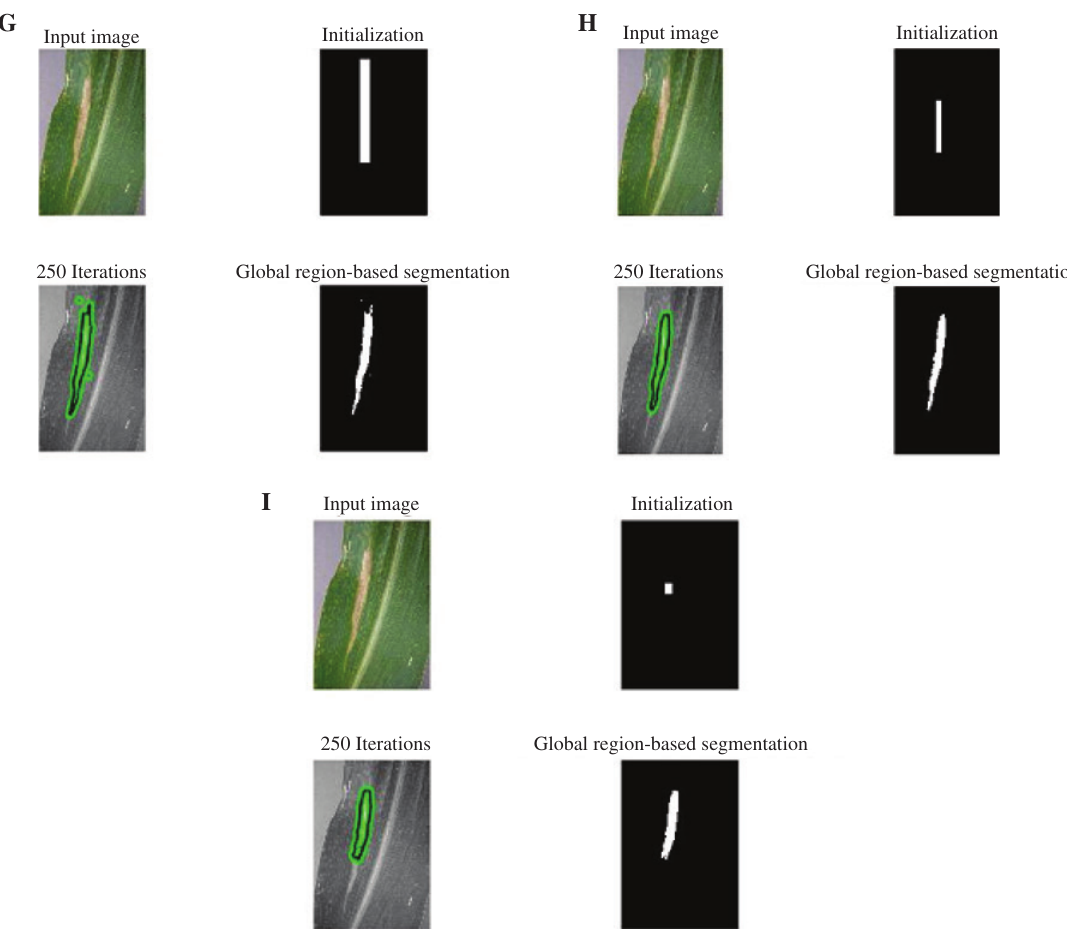
Figure 8: The Output Result of Image